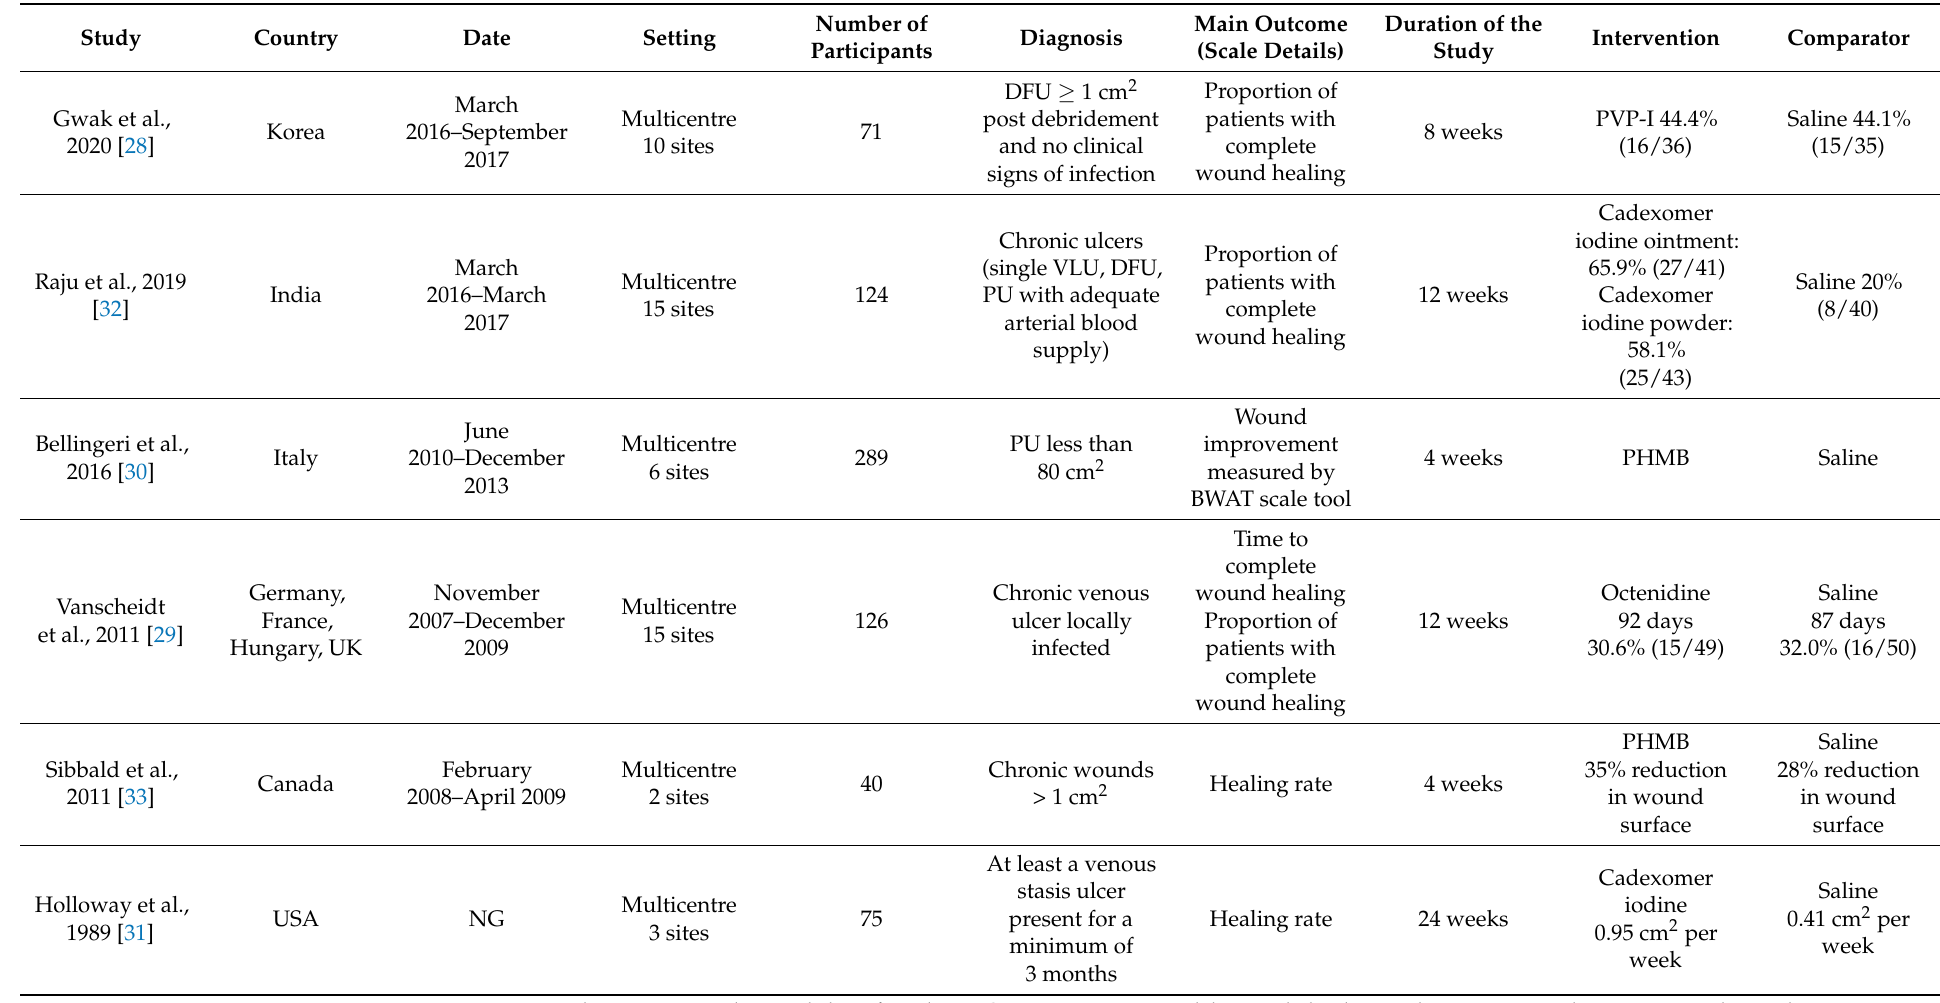
Table 1. Description of included